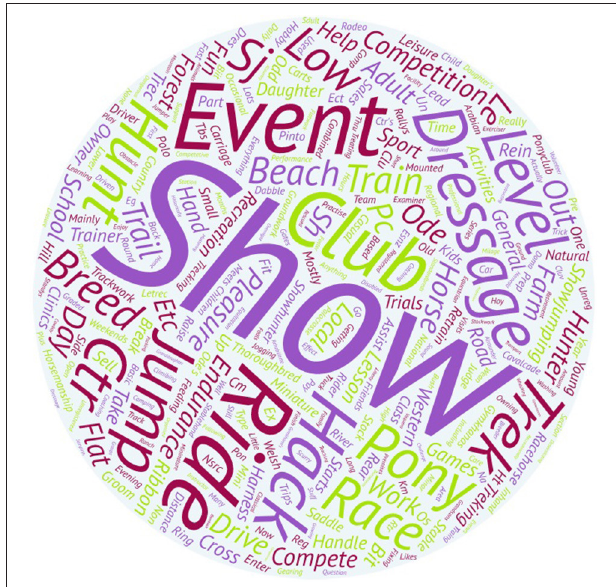
FIGURE 2 | Word art with the description of the amateur activities carried out by the amateur respondents. The size of a particular word represents a frequency of occurrence within the free text responses of the survey participants. In this case, respondents associated horse transport most frequently with the word “show,” followed by “ride” and “event.” “Event” was found to be a significant quantitative contributor to the odds of injury in horses during road transport.